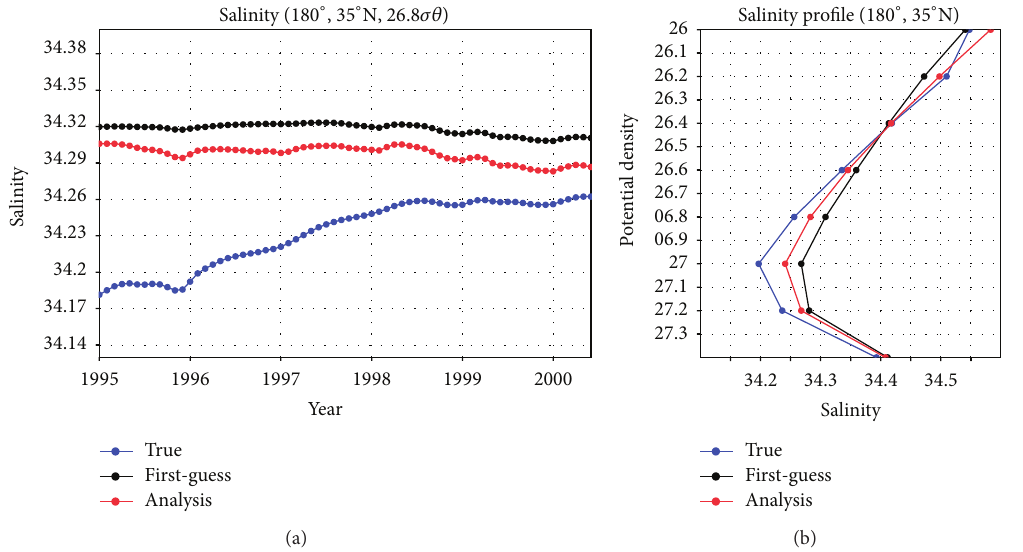
Figure 5: (a) Time series of salinity values on the 26.8 𝜎𝜃 isopycnal surface at 35 ∘ N, 180 ∘ (asterisk in Figure 1), a point remote from the region of synthetic concentrated observations. (b) Vertical salinity profiles at 35 ∘ N, 180 ∘ from 26.0 to 27.4 𝜎𝜃 in January